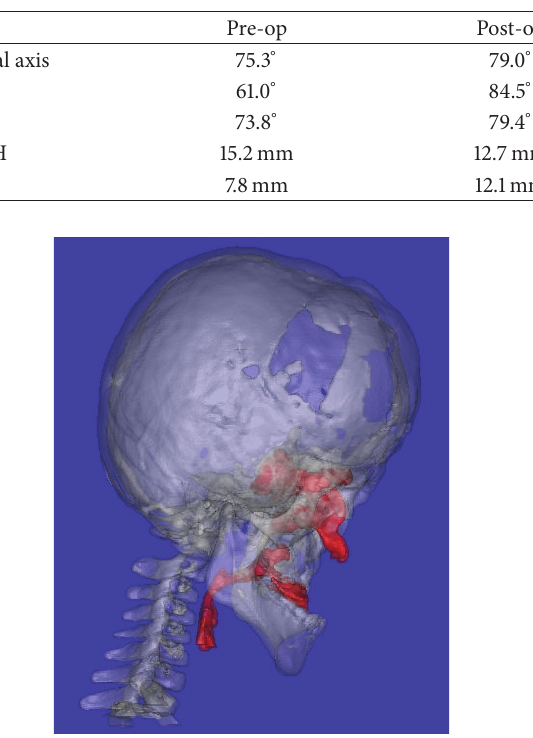
Figure 3: A side view of a three-dimensional computed tomography image obtained before